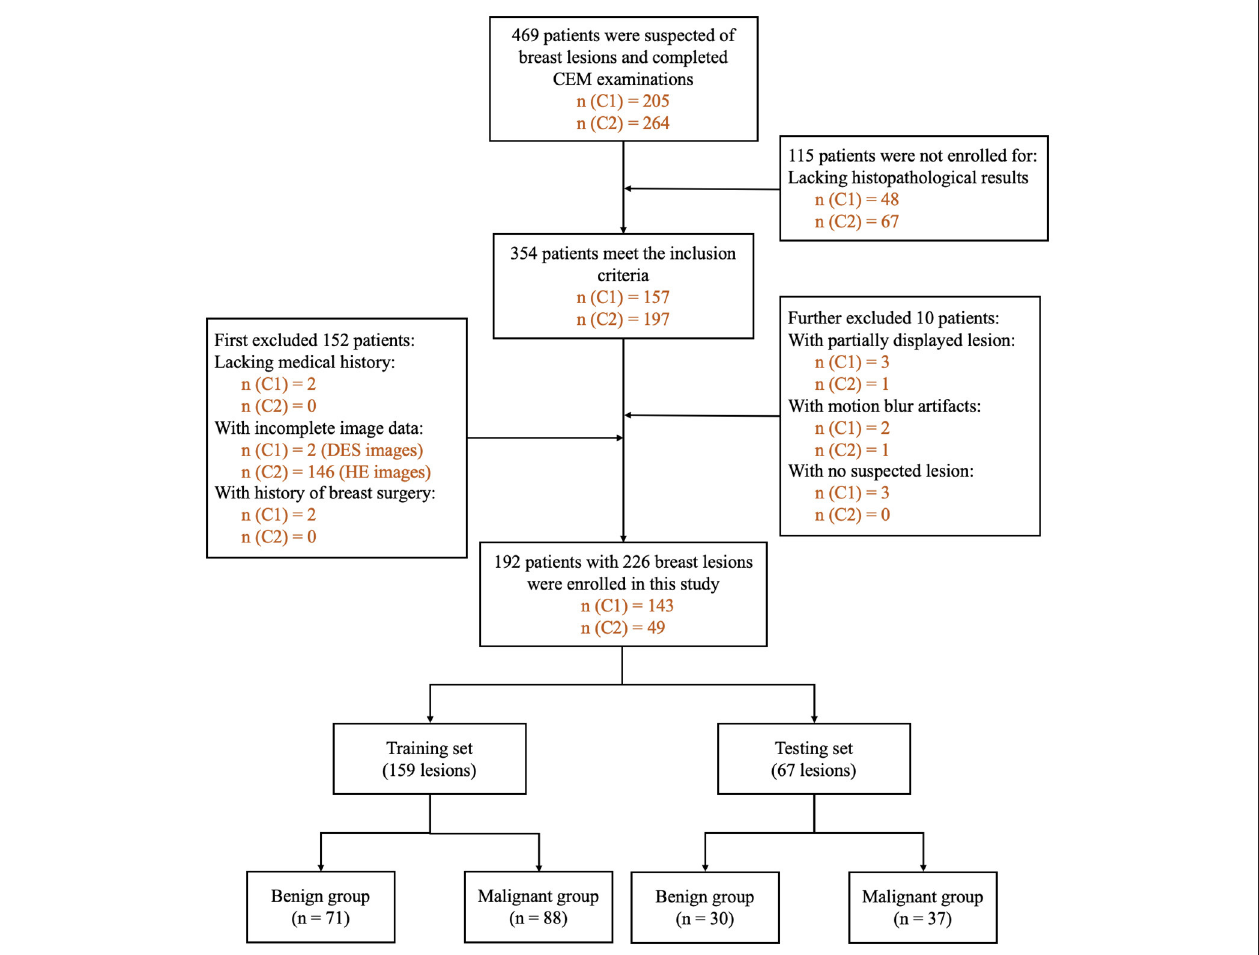
FIGURE 2 | Flowchart of patient inclusion and exclusion criteria. n (C1): number of patients in Research Center 1. n (C2): number of patients in Research Center 2. DES, dual-energy subtraction; HE, high-energy; CEM, contrast-enhanced